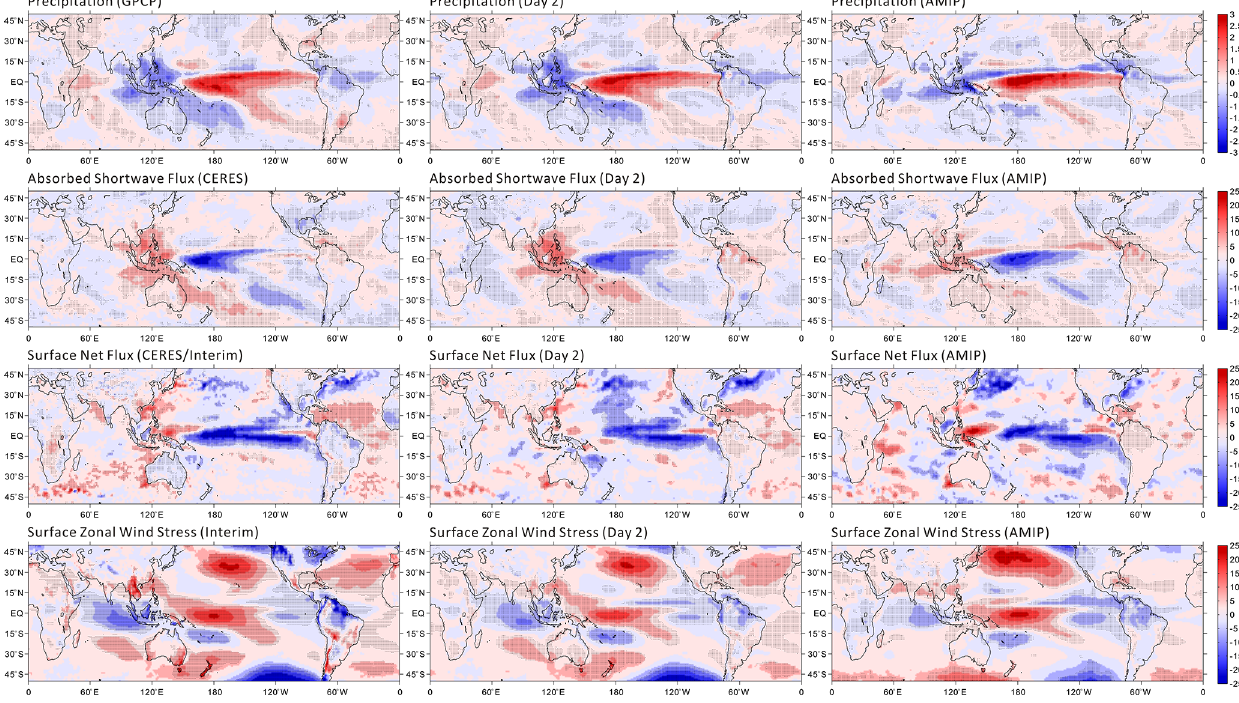
Figure 7. Regression maps of precipitation (mmd − 1 K − 1 ), absorbed shortwave radiation (Wm − 1 K − 1 ), net surface heat flux (Wm − 1 K − 1 ), surface zonal wind stress (Nm − 2 K − 1 ) onto the Niño3.4 index from observations (left panels), day 2 hindcasts (middle panels), and AMIP simulation (right panels). Table 3. Pattern statistics of regression maps of selected fields onto the Niño3.4 index between observations and model simulations (day 2 hindcasts or AMIP). Spatial correlation RMSE Normalized spatial coefficient standard deviation Day 2 AMIP Day